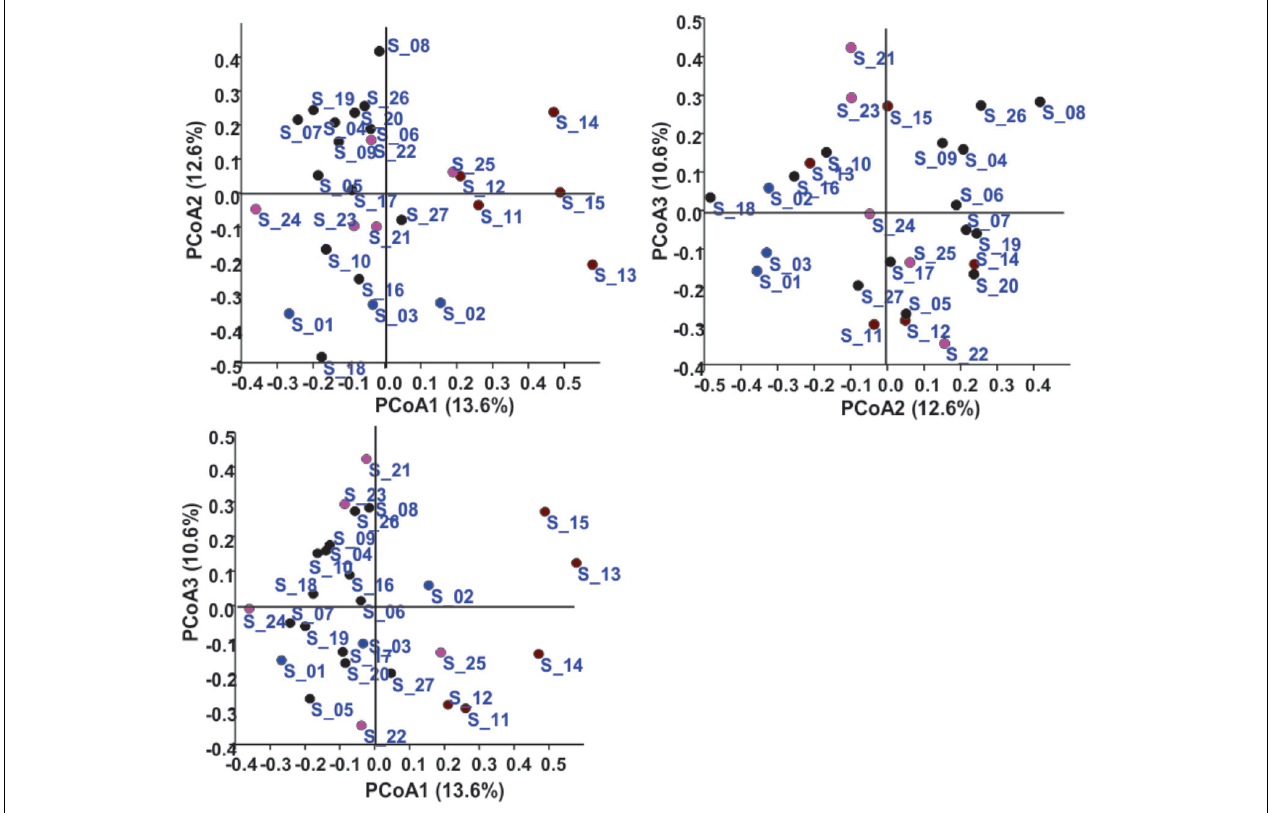
FIGURE 4 | Principal coordinate analysis based on the microbial communities isolated from the samples collected of cellular phones. Circles in different colors represent sample collected from the cellular phones of individuals working in laboratories